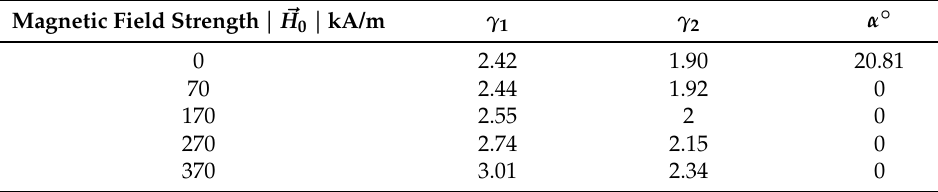
Table A1. Magneto-induced deformation and re-orientation of the